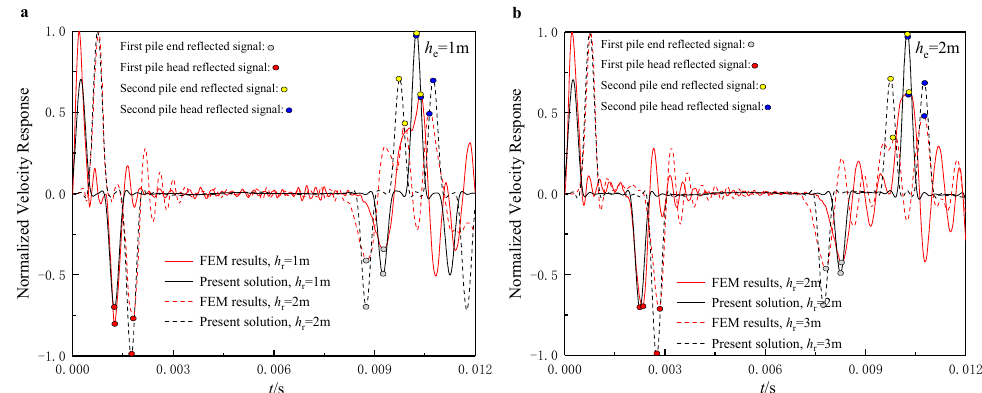
Figure 4. Comparisons of velocity response between present solution and FEM results: ( a ) h e = 1 m; ( b ) h e = 2 m.